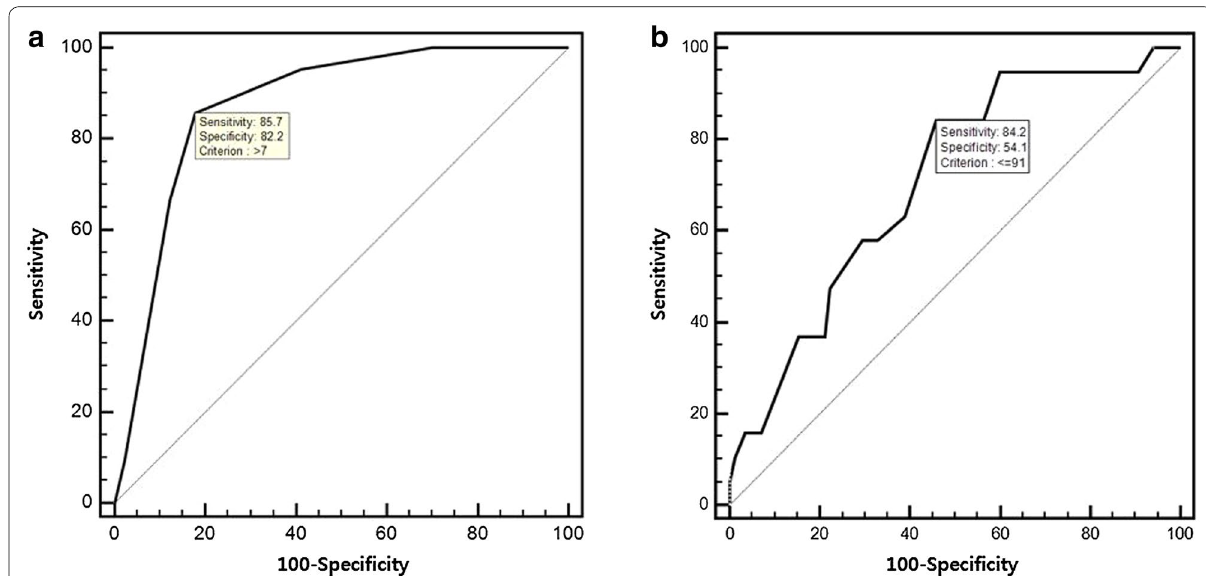
Fig. 2 Receiver operating characteristic curves for predicting survival. a The prediction scoring model. b SAPS